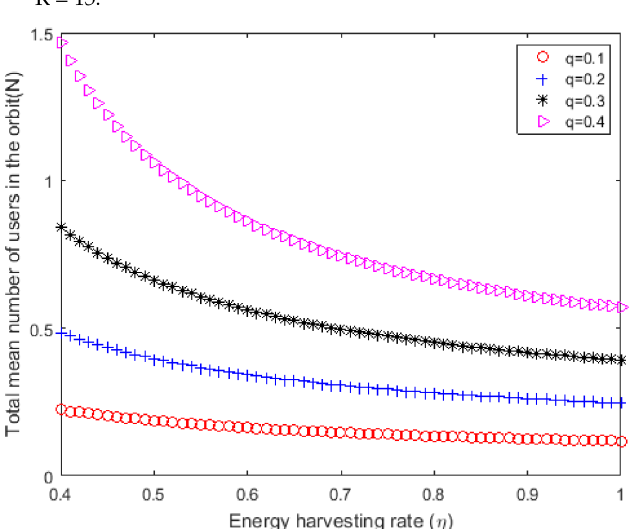
Figure 11. Energy-harvesting rate ( η ) vs. total mean number of users in orbit.